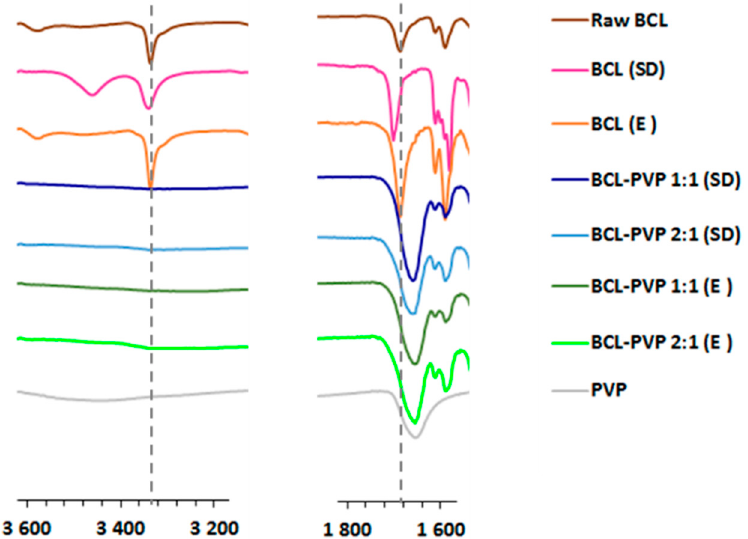
Figure 3. The comparison of FTIR spectra of raw bicalutamide, drug processed without a carrier and BCL–PVP solid dispersions.